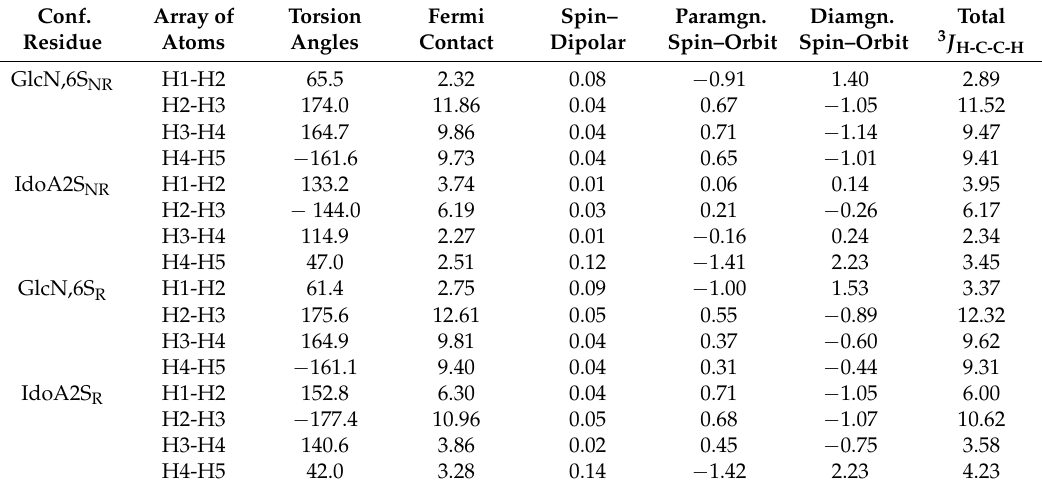
Table 6. DFT–computed (B3LYP/6-311+(d,p)) Fermi contact, spin–dipolar, paramagnetic spin-orbit and diamagnetic spin-orbit contributions to the three-bond proton–proton coupling constants (values in Hz) in form 2 of the heparin tetrasaccharide. Total 3 J H-C-C-H magnitudes are listed in the final column. Conf.